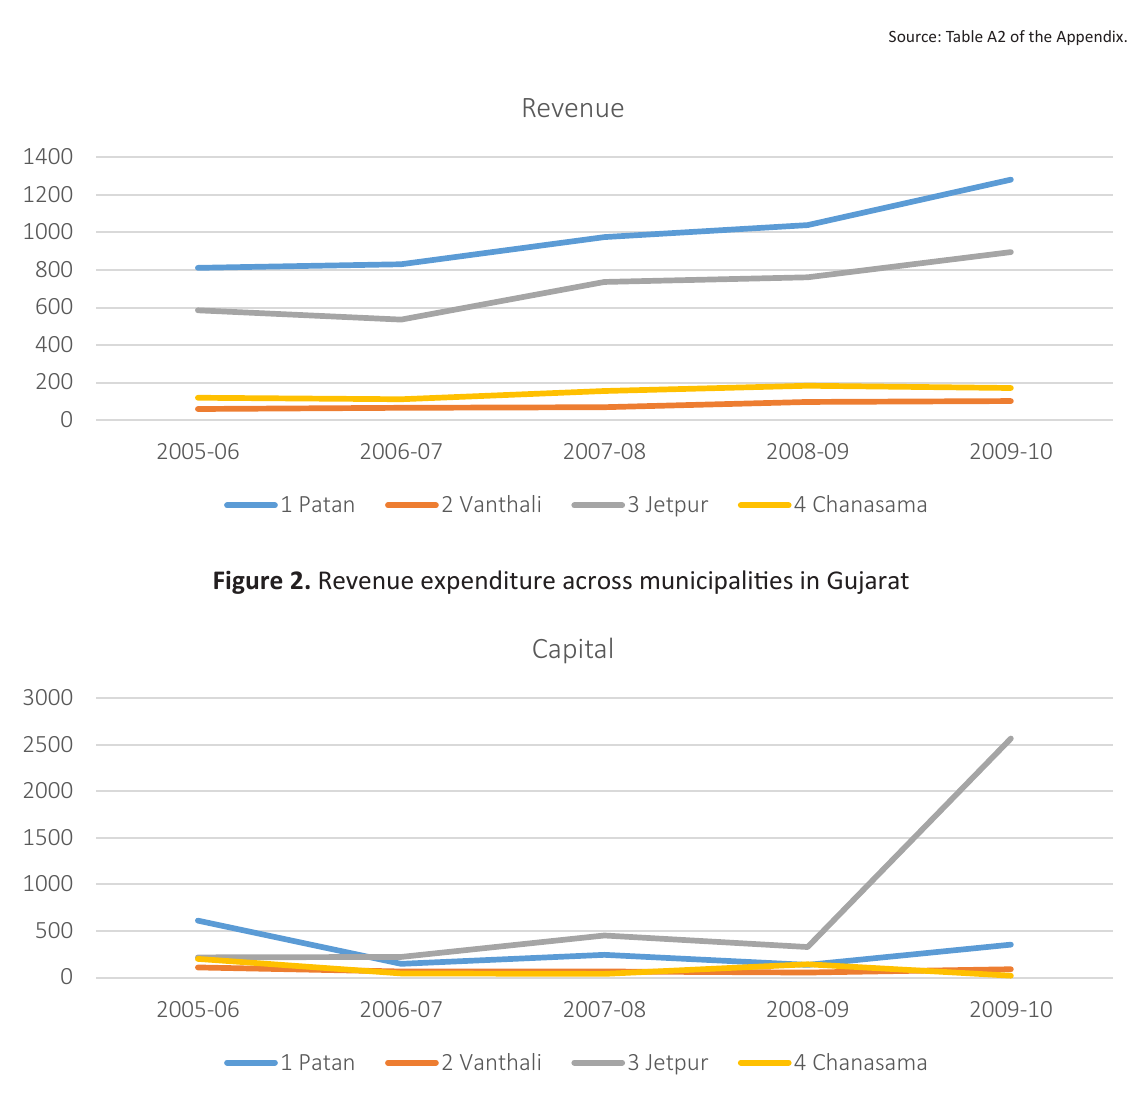
Figure 3. Capital expenditure across municipalities in